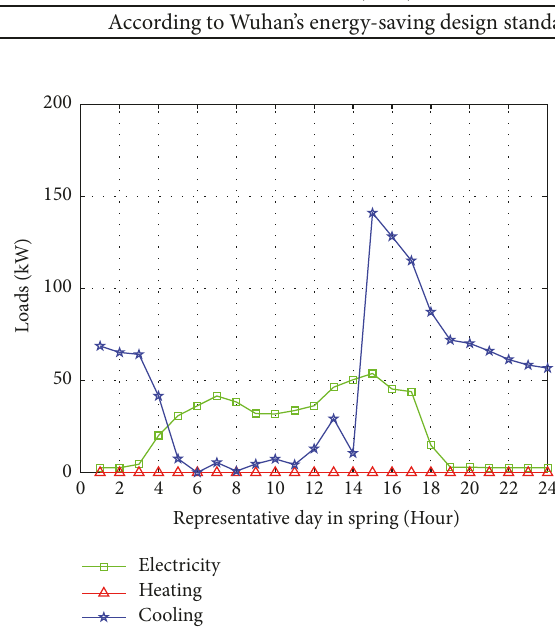
Figure 3: Hourly energy requirements in a spring